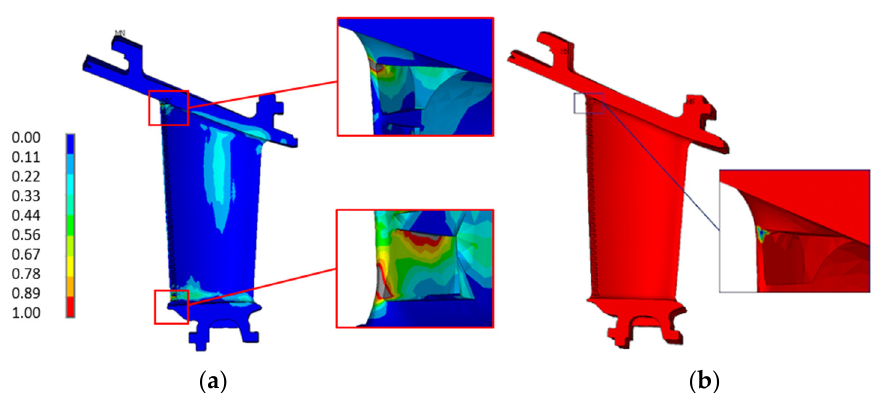
Figure 17. Damage analysis results. ( a ) Creep analysis at 66 kFH, where the creep limit is exceeded in critical areas; ( b ) LCF analysis with no stress relaxation.